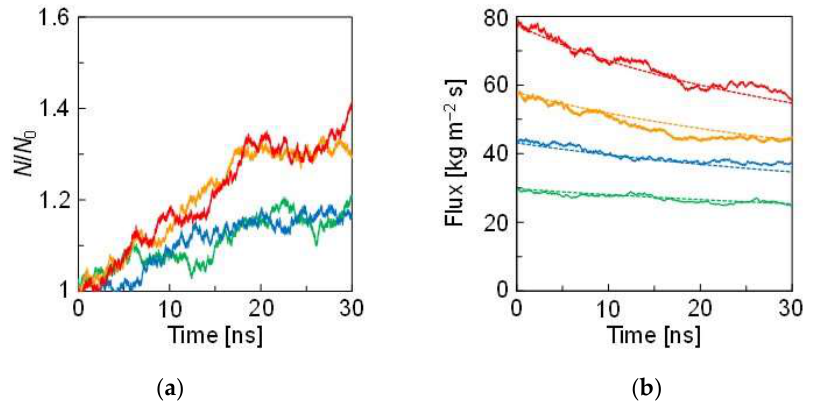
Figure 3. Changes in ( a ) N / N 0 and ( b ) the flux during NEMD. The green, blue, orange, and red lines represent 3.0, 4.5, 5.9, and 9.1 wt.% of the solute concentrations, respectively. The solid and dotted lines are obtained by NEMD and Equation (3), respectively.